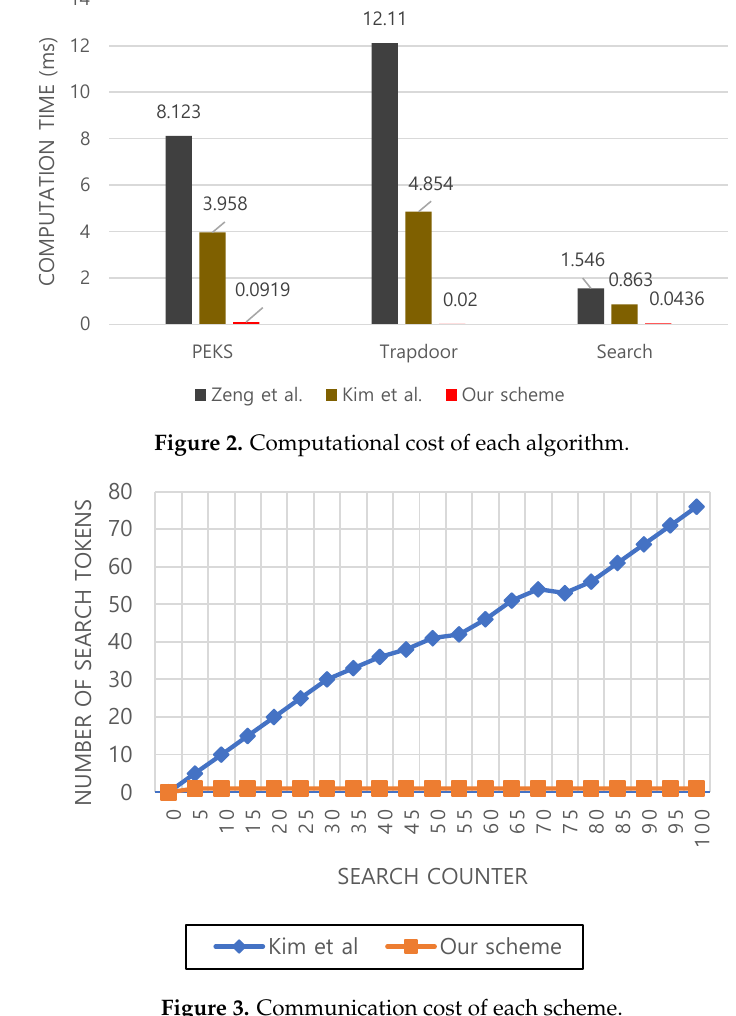
Figure 3. Communication cost of each scheme.